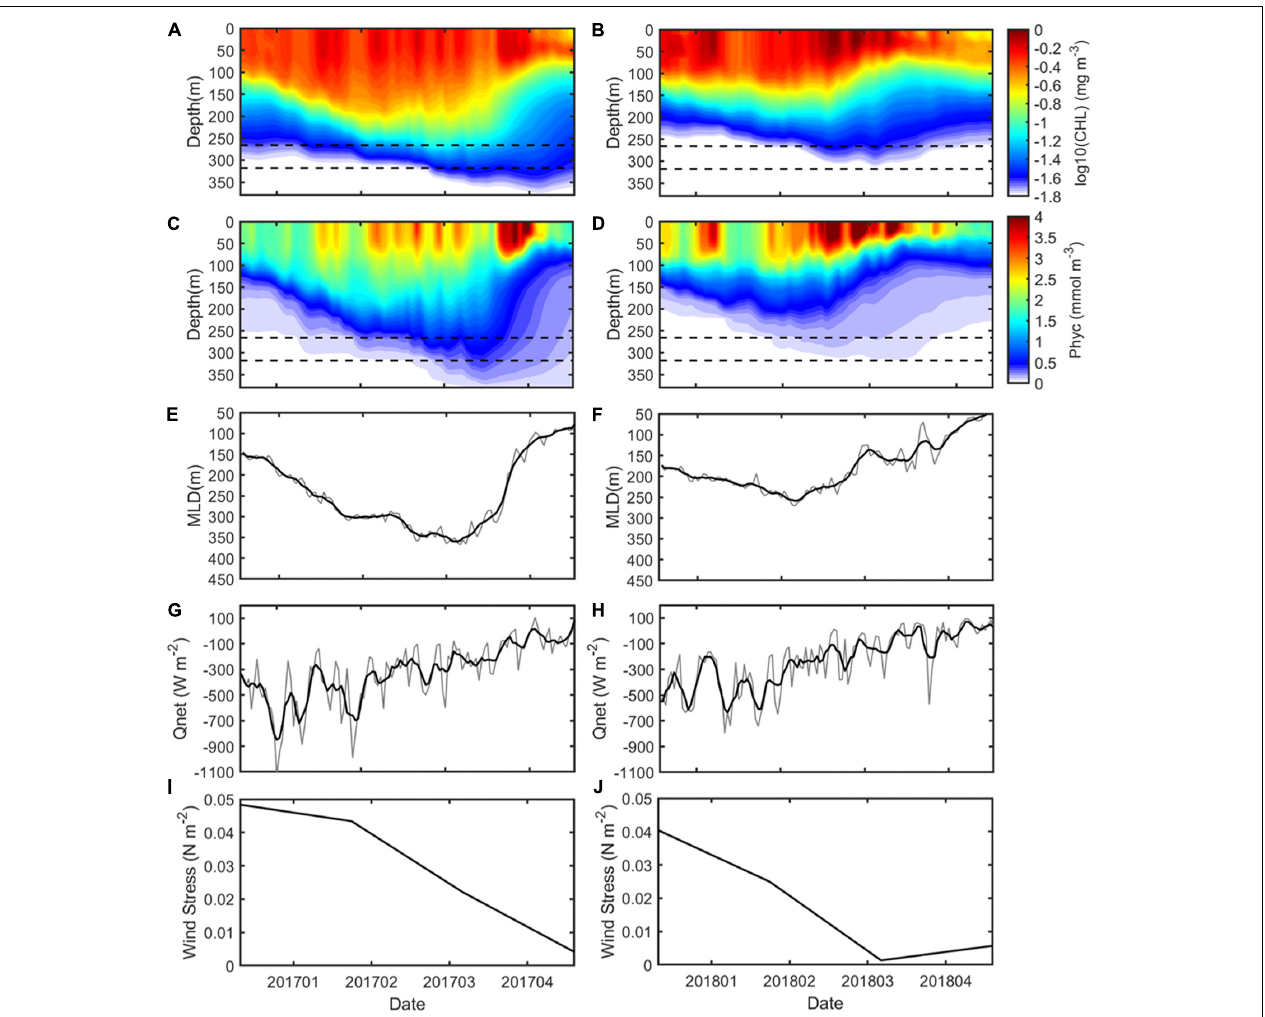
FIGURE 11 | Time series of regionally averaged CHL, total phytoplankton (Phyc), MLD, Qnet, and wind stress in 2017 (A,C,E,G,I) and 2018 (B,D,F,H,J) . The dotted lines in panels (A–D) represent depths at 266 m and 318